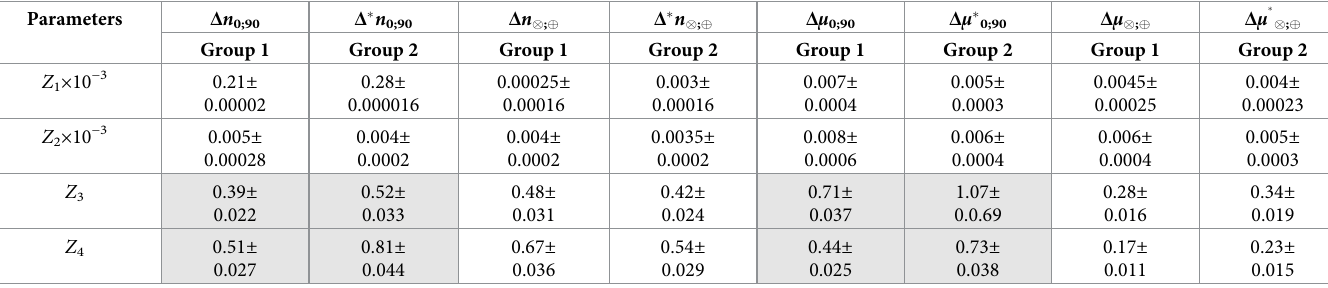
Table 2. Parameters of the statistical analysis of myocardium polarization-phase images. Parameters